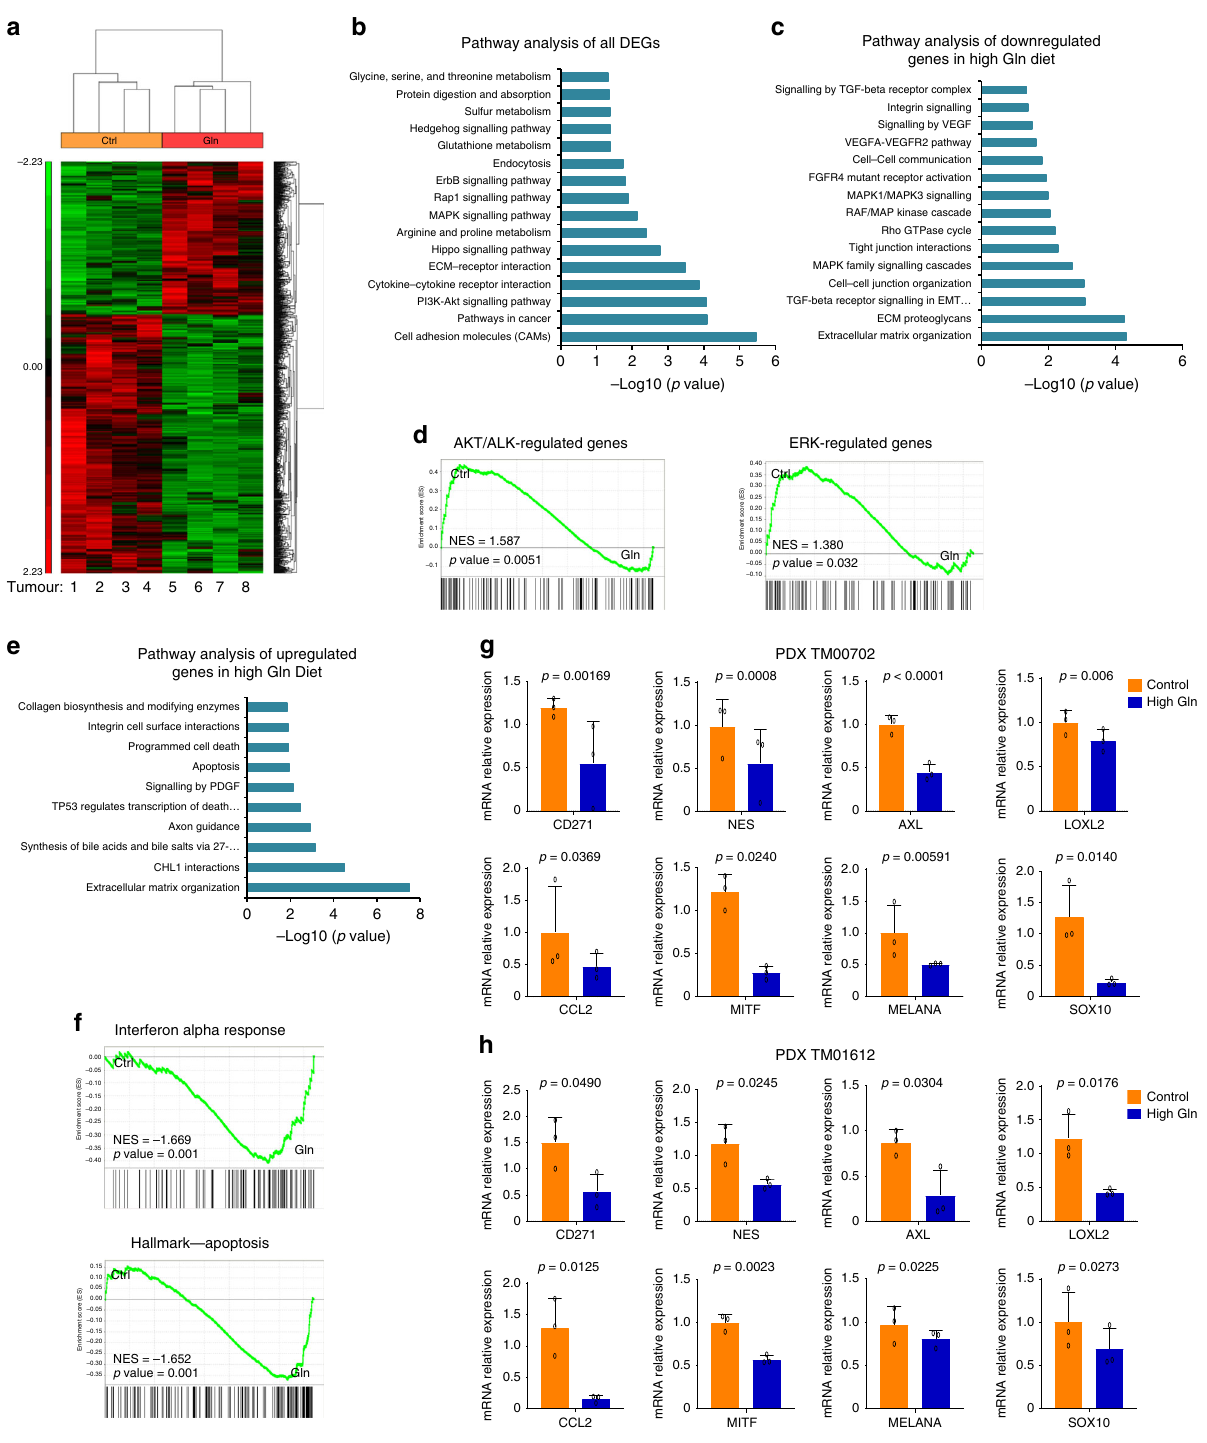
Fig. 4 High glutamine downregulates melanoma-associated oncogenes. a Hierarchical clustering and heat map of differentially expressed genes (DEGs) in PDX_TM00702 tumours from control (Ctrl) or glutamine supplementation (Gln) mice groups ( n = 4, biological replicates). b Pathway enrichment analysis of all DEGs ( p < 0.05 and FDR < 0.05) in Gln versus Ctrl groups with fold change = ±1.5. c Pathway enrichment analysis of DEGs downregulated in Gln versus Ctrl groups with fold change ≥ 1.5, p < 0.05 and FDR < 0.05. d GSEA analysis in control (Ctrl) versus glutamine supplemented (Gln) tumours. e Pathway enrichment analysis of DEGs upregulated in Gln versus Ctrl groups with fold change < − 1.5, p < 0.05 and FDR < 0.05. f GSEA analysis in control (Ctrl) versus glutamine supplemented (Gln) tumours. g , h Melanoma-associated oncogenes expression in PDX_TM00702 in g and PDX_TM01612 in h tumours veri fi ed by qPCR ( n = 3, biological replicates performed in triplicates). Data represent means and error bars are s.d. p value calculated by t test (unpaired, two tailed). Source data are provided as a Source data fi